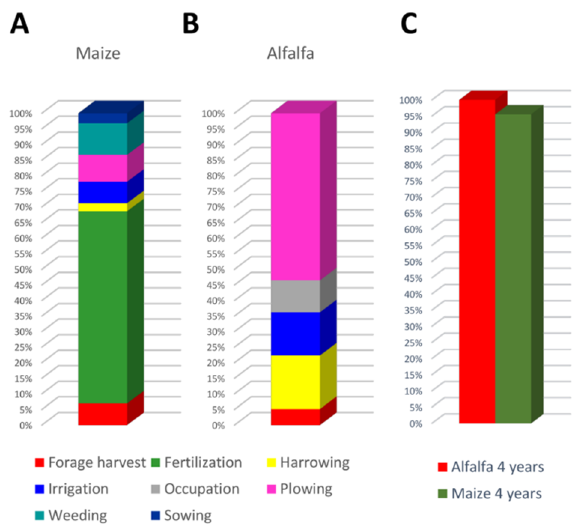
Figure 8. Maize’s combined impacts in milli-Points (mPt) in a single year ( A ); alfalfa’s combined impacts in milli-Points (mPt) in the first year ( B ) (IPCC 2013 GWP 100y). ( C ) Comparison between the two crops characterization phase (IPCC 2013 GWP 100y).